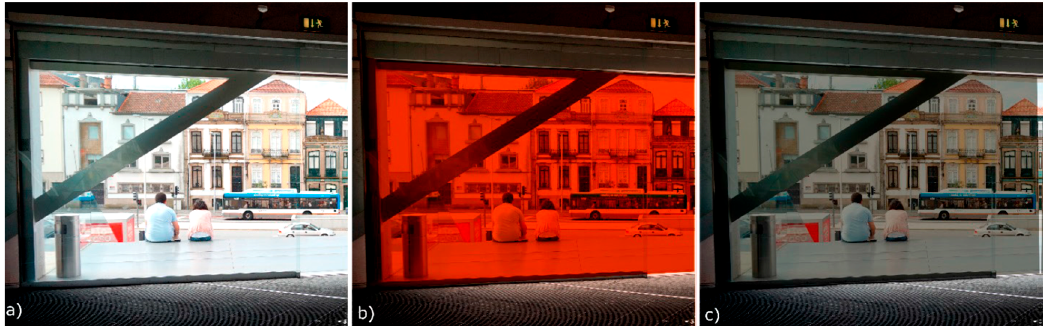
Figure 8. Simulation of the appearance of the different PV technologies applied to the glazing such as ( a ) baseline condition; ( b ) a-Si cell and ( c ) PSC. Reprinted with permission [199].